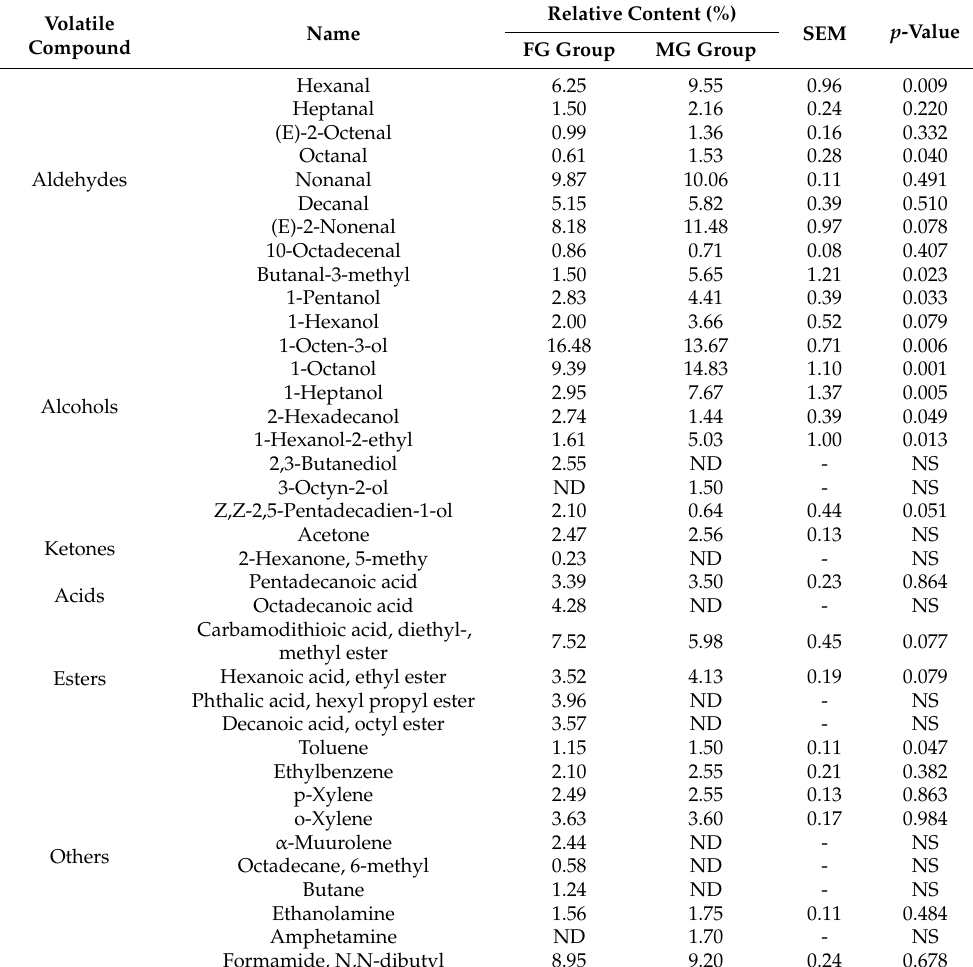
Table 7. Volatile flavor compounds of LT muscle of goats in two groups.